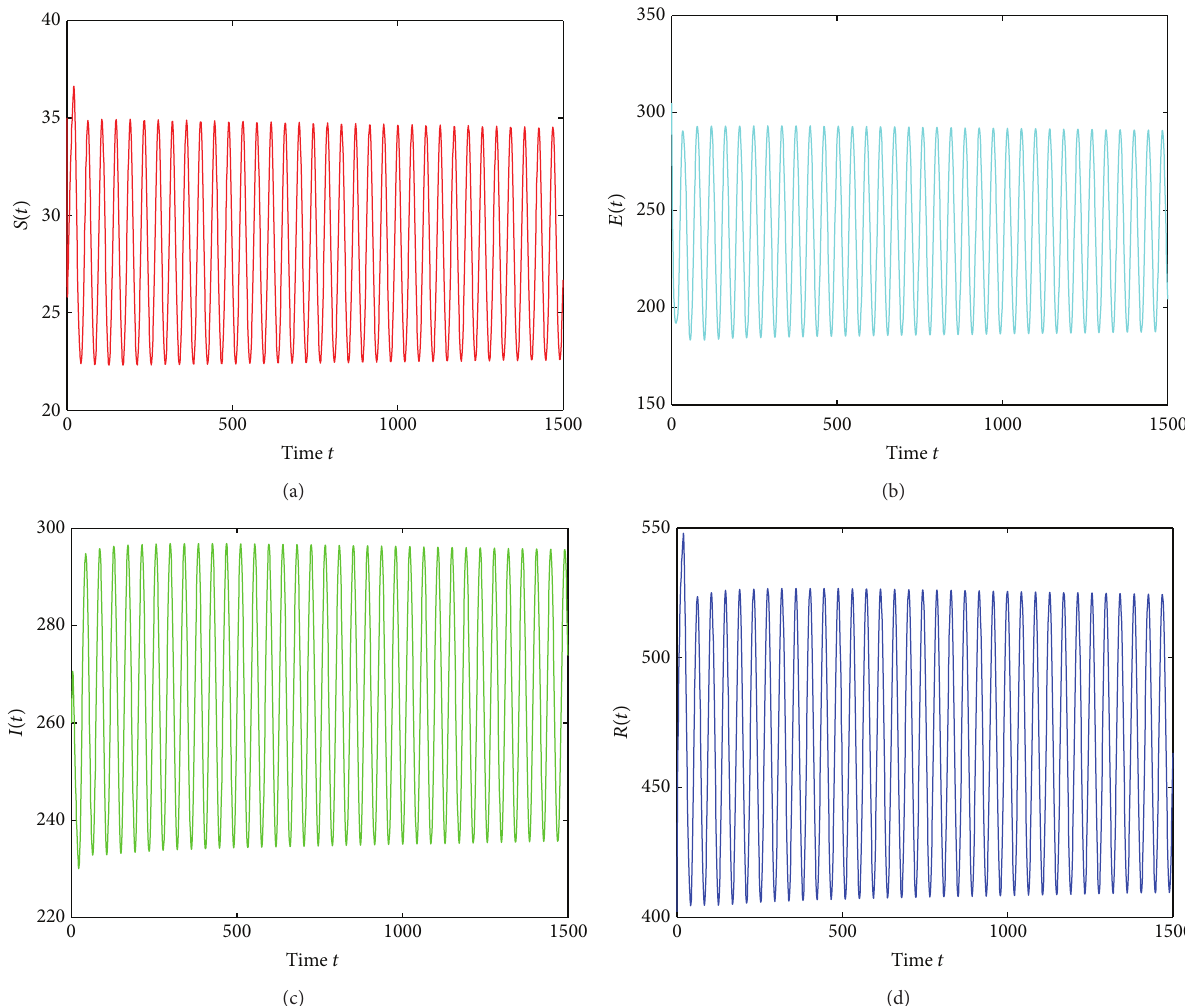
Figure 3: The track of the states 𝑆 , 𝐸 , 𝐼 , and 𝑅 for 𝜏 1 = 20.0500 > 17.2530 = 𝜏 10